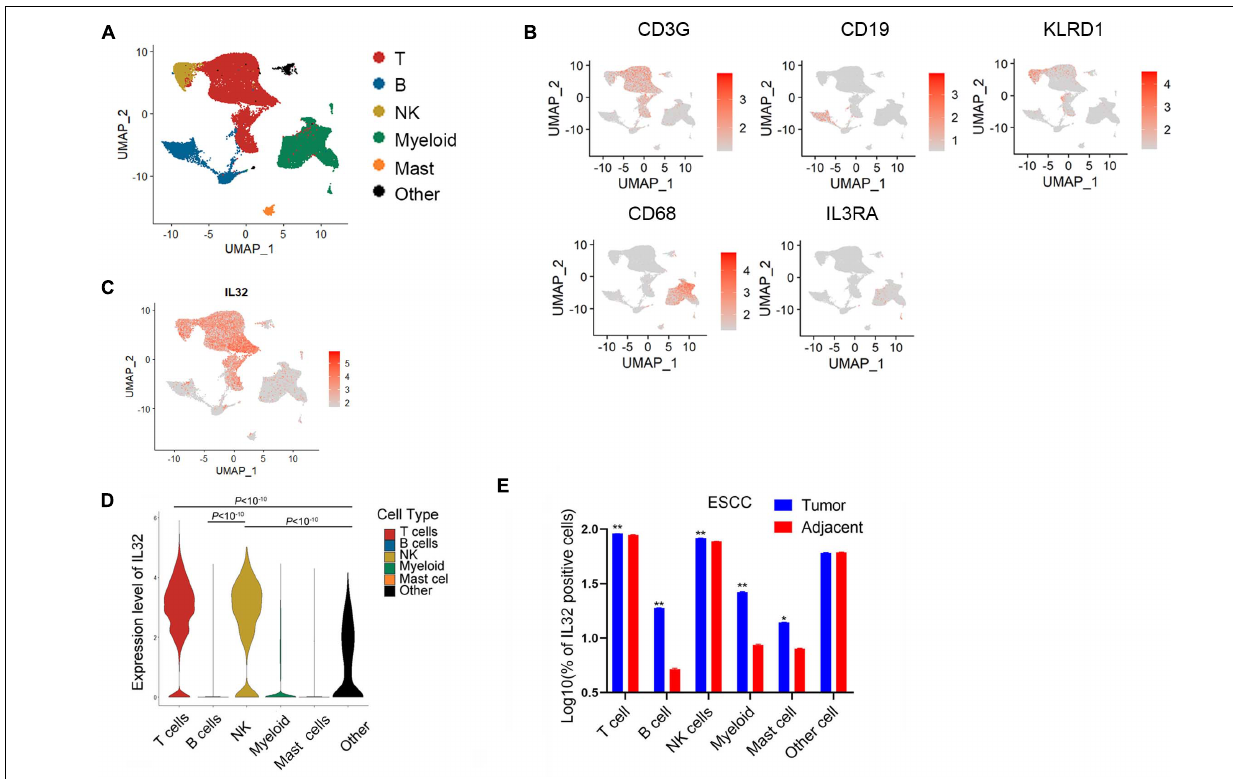
FIGURE 1 | Overexpression of IL-32 in T and NK cells in the ESCC TME. (A) UMAP plot of immune cells from the tumor tissues of seven ESCC patients to visualize cell-type clusters based on the expression of known marker genes, main clusters shown in different colors. (B) Expression levels of relative marker genes illustrated as UMAP plots. The expression was measured as the log2 (count + 1). (C) Expression levels of IL-32 illustrated as UMAP plots. The expression was measured as the log2 (count + 1). (D) Violin plot shows the IL-32 expression in T cell, B cell, NK cell, myeloid, mast cell, and other cell subsets in the ESCC. p Value adjustment was performed using Bonferroni correction then was calculated by Wilcoxon signed rank test. (E) Box plot shows the IL-32–positive cells between the tumor and adjacent group in T cell, B cell, NK cell, myeloid, mast cell, and other cell subsets of ESCC ( n = 7). The data were measured as the log10 (% of positive cells). p Value was calculated by two-tailed Student t test. ** p < 10 - 10 , * p <